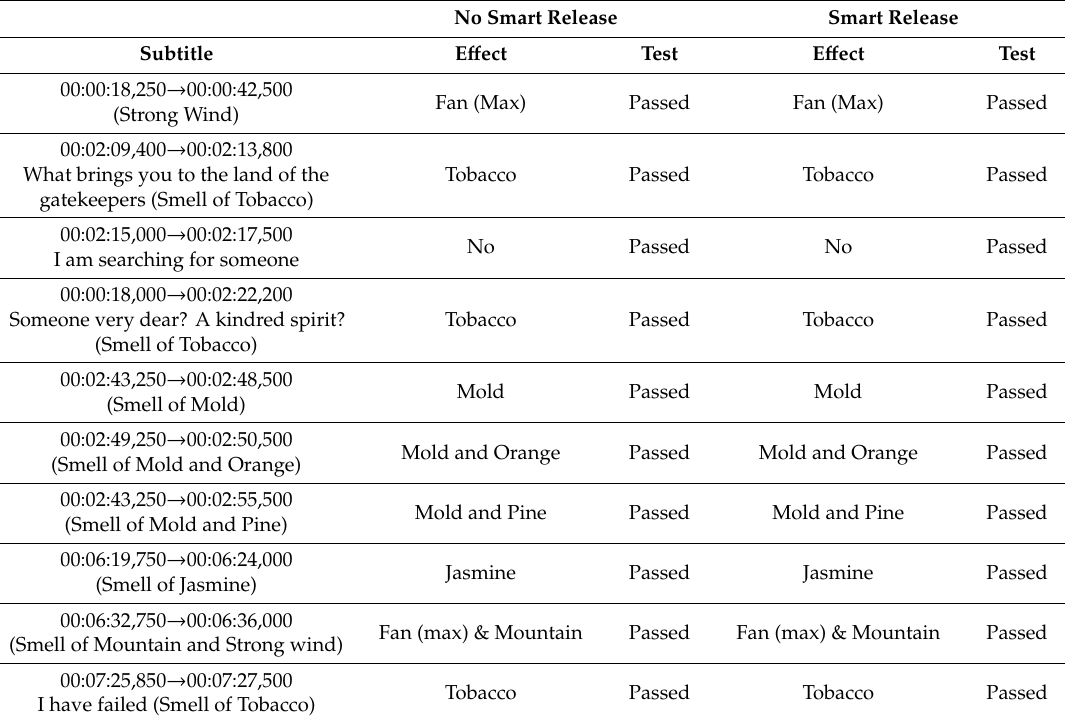
Table 2. Subtitle Mode